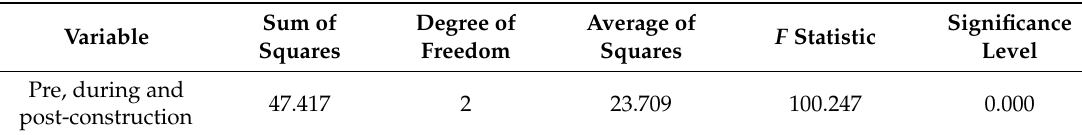
Table 10. Results of the test of within-subjects’ e ff